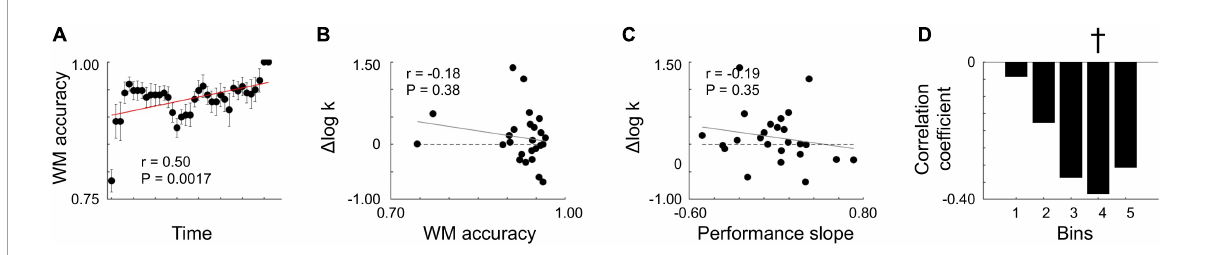
FIGURE5 Individual performance enhancement in working memory training is not associated with level of impulsivity reduction (experiment 2). (A) The participants showed a significant performance improvement in the working memory task over time (Pearson’s correlation r = 0.50, P = 0.0017). Each dot represents mean accuracy within each window across participants, and error bars indicate s.e.m. (B) Individuals’ overall working memory performance was not associated with changes in their delay discounting rates ( r = –0.18, P = 0.38, bootstrapping P = 0.36). (C) Individuals’ speed of working memory performance enhancement (performance slope) was not correlated with level of impulsivity reduction ( r = –0.19, P = 0.35, bootstrapping P = 0.35). Each dot represents an individual, and solid red lines are robust regression lines. (D) Over the course of the working memory task, no significant association was observed between individuals’ working memory task accuracy and their impulsivity reduction level; if any, there were negative trends that showed that the individuals tended to show more impulsive choices in the post-intervention ITC task. † <